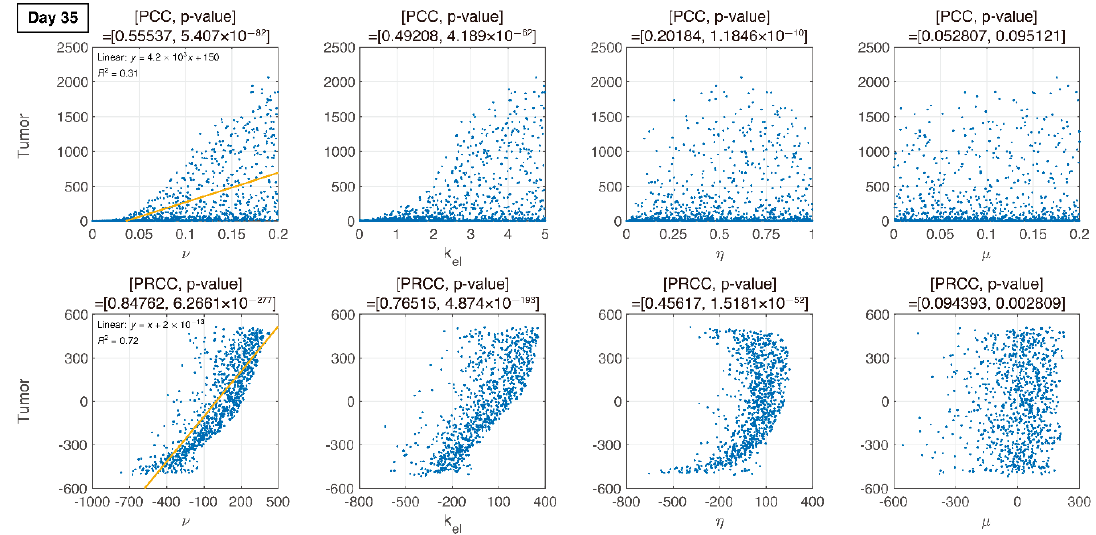
Figure 9. In the final phase, the elimination rate of IT, k el , is proportional to tumor growth. ν remains proportional to tumor growth.